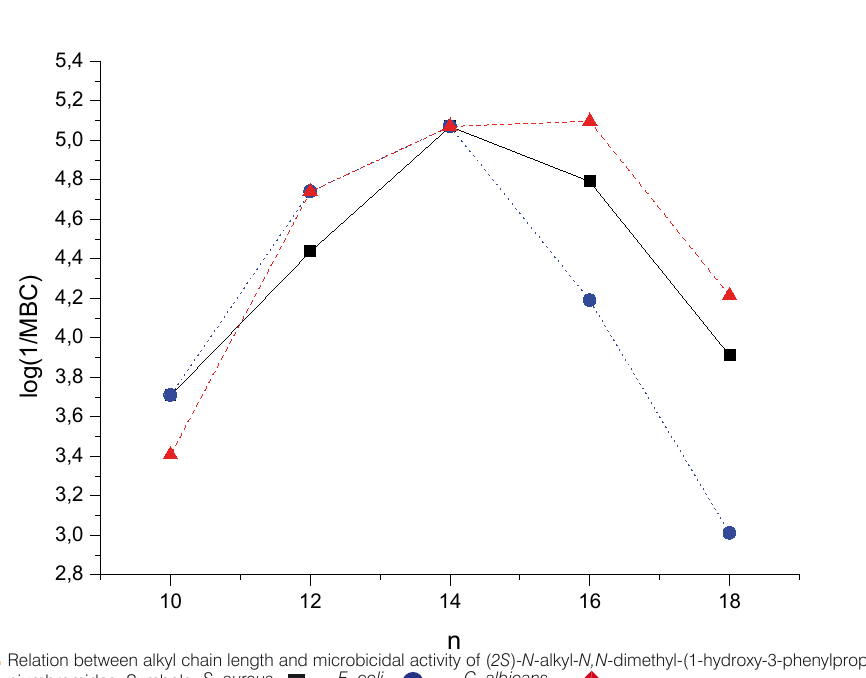
Figure 2. Relation between alkyl chain length and microbicidal activity of ( 2S )- N -alkyl- N,N -dimethyl-(1-hydroxy-3-phenylpropyl)-2-ammo - niumbromides; Symbols: S. aureus E. coli C. albicans